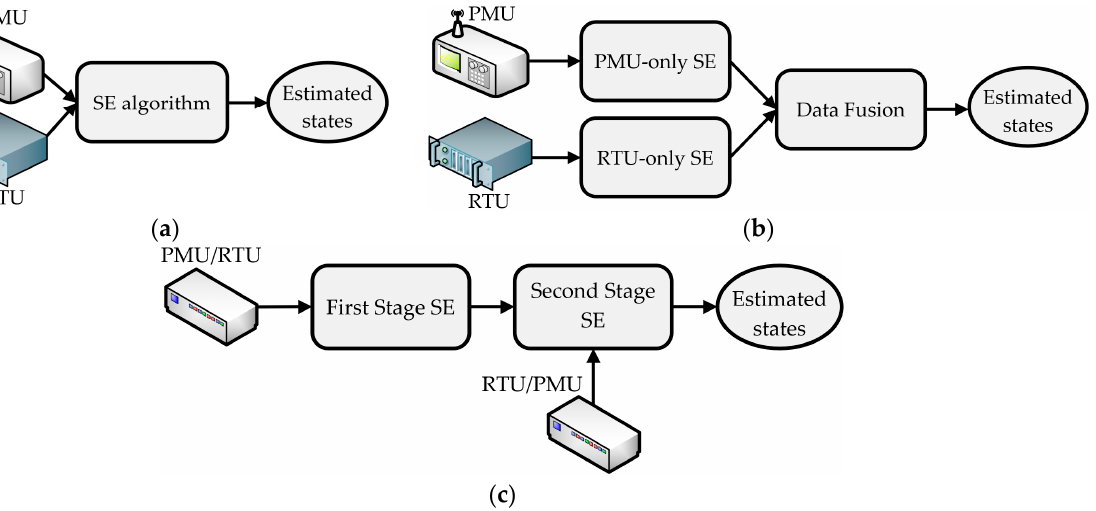
Figure 4. Typical structure of HSSE methods: ( a ) One-Stage HSSE; ( b ) Fusion HSSE; ( c ) Two-Stage